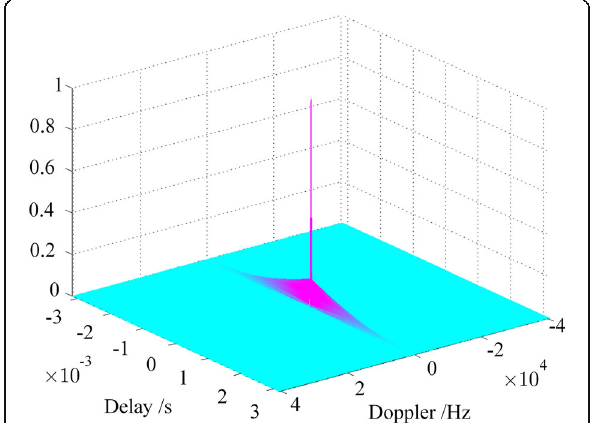
Fig. 7 The ambiguity graph of CE-OFDM RadCom time-domain transmitted signals